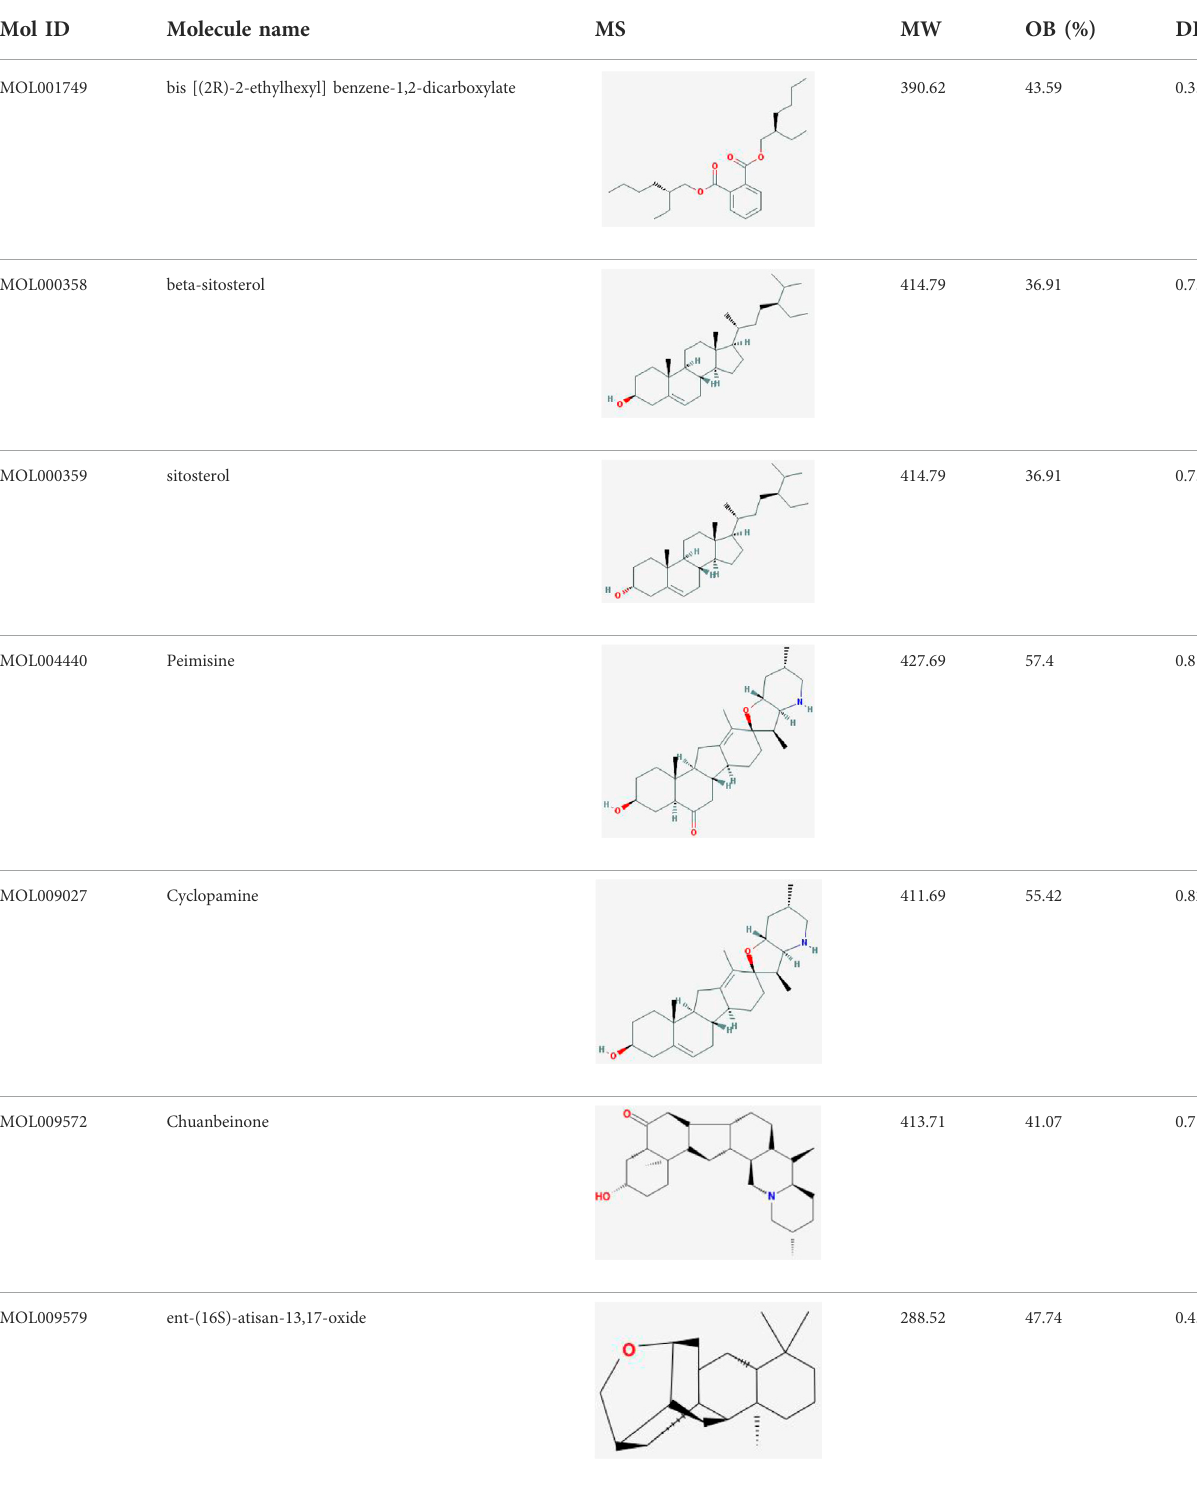
TABLE 1 13 active compounds of Fritiliariae Irrhosae